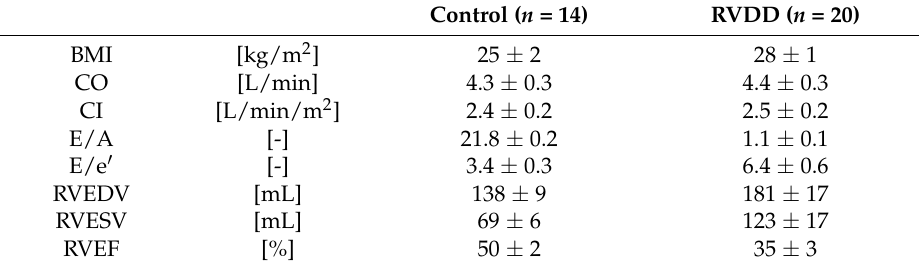
Table 1. Control and right ventricular diastolic dysfunction (RVDD) cohort characteristics. Values are mean ± SE. BMI, body mass index; CO, cardiac output; CI, cardiac index; E/A, Tricuspid early and late velocity ratio; E/e’, Early fluid to lateral tricuspid velocity ratio; RVEDV, right ventricular end diastolic volume; RVESV, right ventricular end systolic volume; RVEF, right ventricular ejection